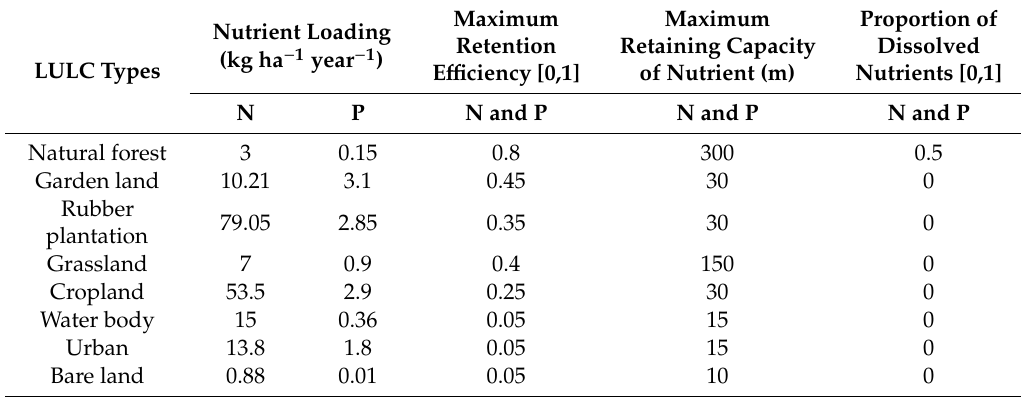
Table 3. Biophysical coe ffi cients for Nutrient Delivery Ratio (NDR) module in